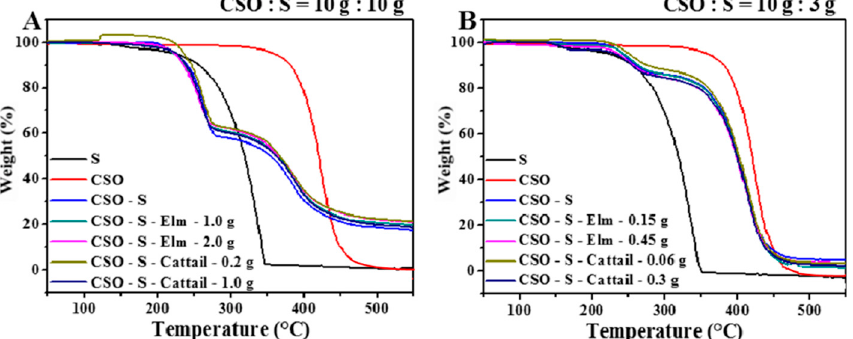
Figure 6. Thermogravimetric analysis (TGA) curves of sulfur, cottonseed oil (CSO) and bio-based polysulfide composites. ( A ) 10.0 g CSO + 10.0 g S + different fillers, ( B ) 10.0 g CSO + 3.0 g S + different fillers.